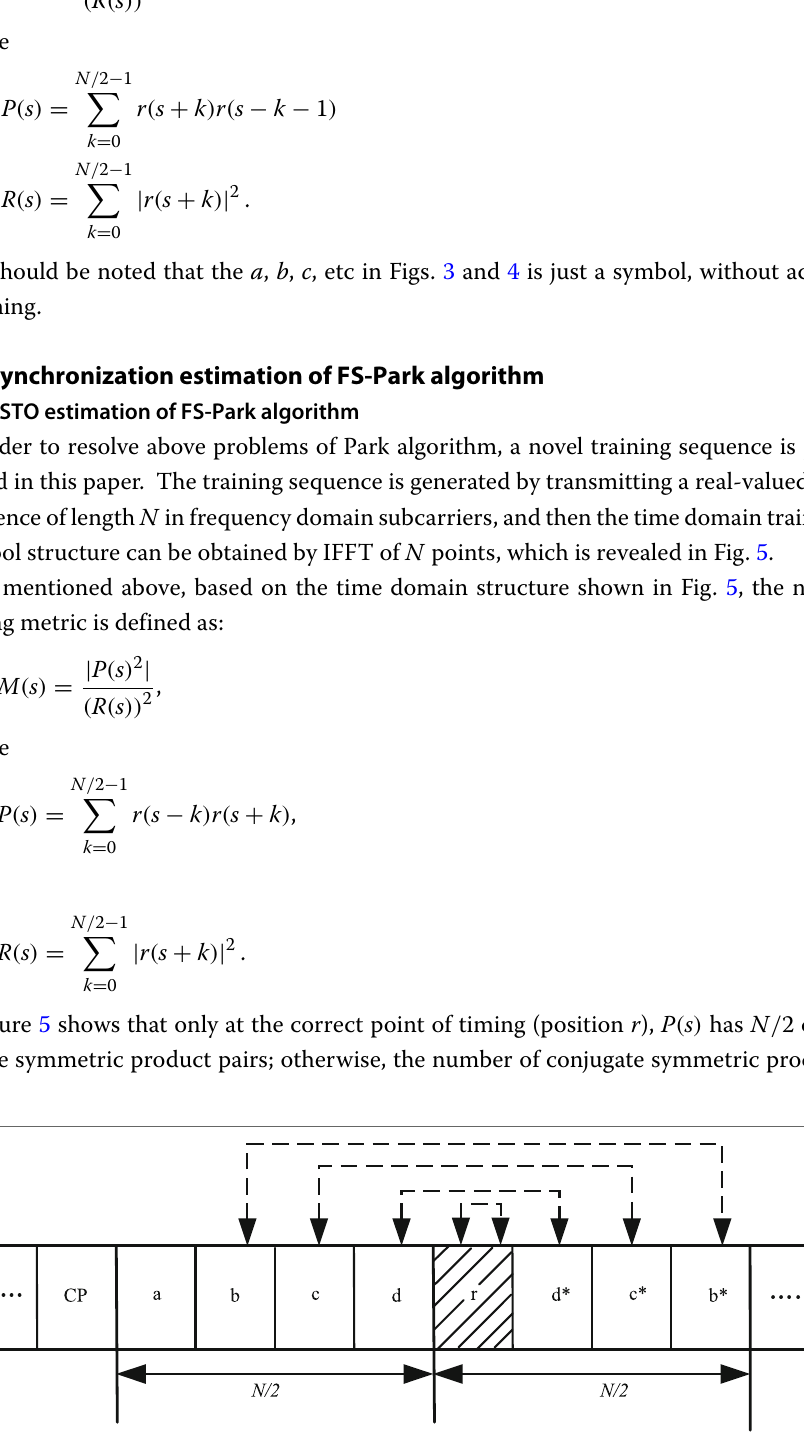
Fig. 5 Time domain symbol structure of FS-Park